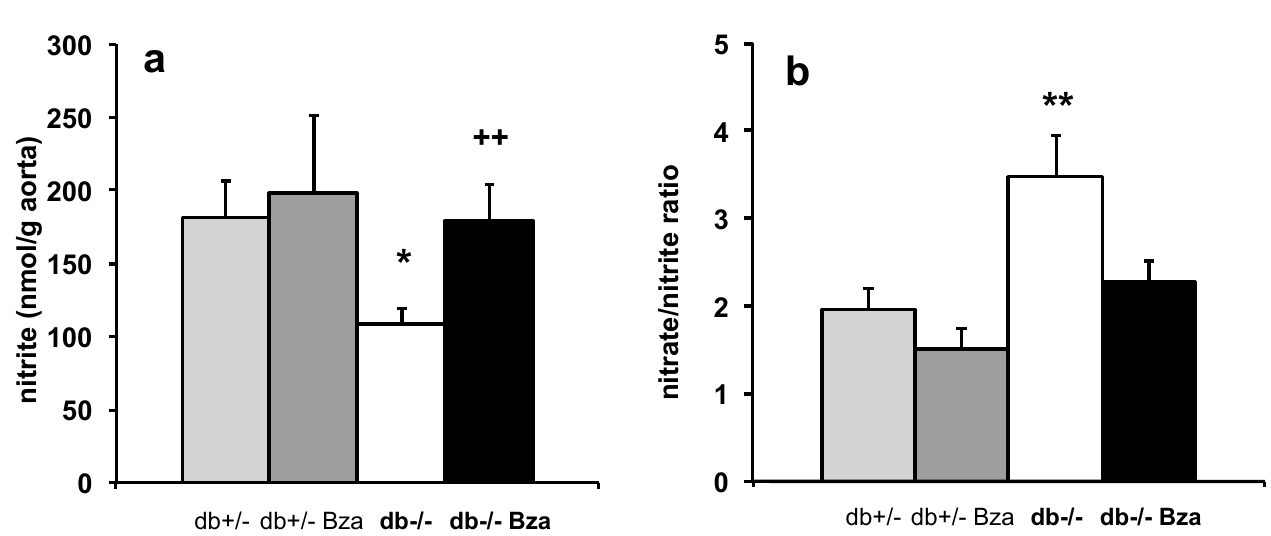
Figure 7. Nitrite levels ( a ) and nitrate/nitrite ratio ( b ) in aorta of db+/- (light grey), db-/- (white) and Bza-treaded db+/- (dark grey) and db-/- (black) mice. Data are means ± SEM of 5-14 determinations; significant difference at * p < 0.05 and ** p < 0.01 for db-/- vs. db+/-; ++ p < 0.01 for db-/- vs.